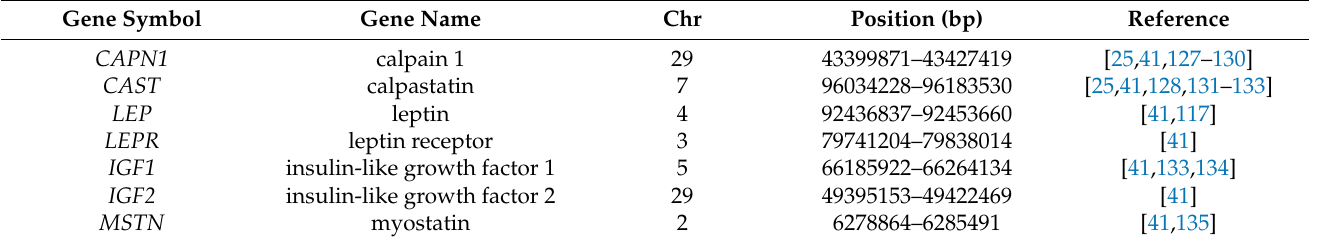
Table 3. Description and chromosomal location of the most important genes related to eye muscle area in Hanwoo